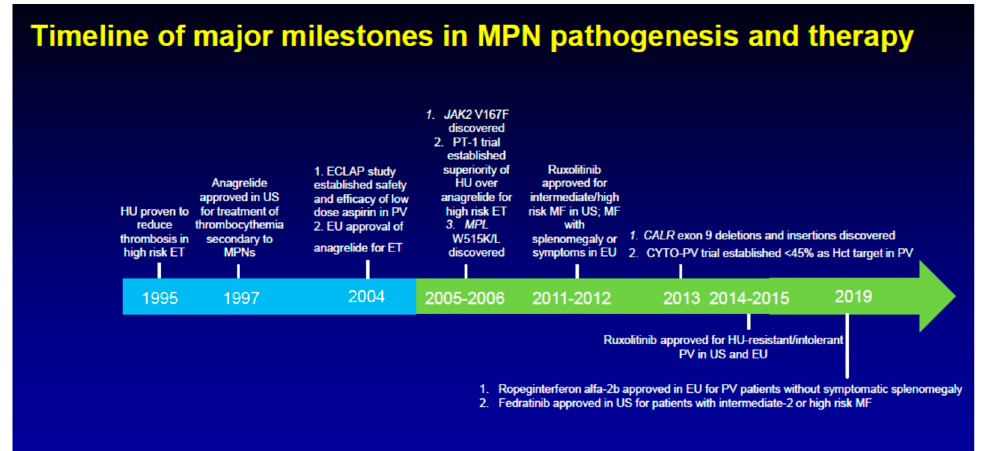
Figure 1. Timeline of major milestones in MPN pathogenesis and therapy.